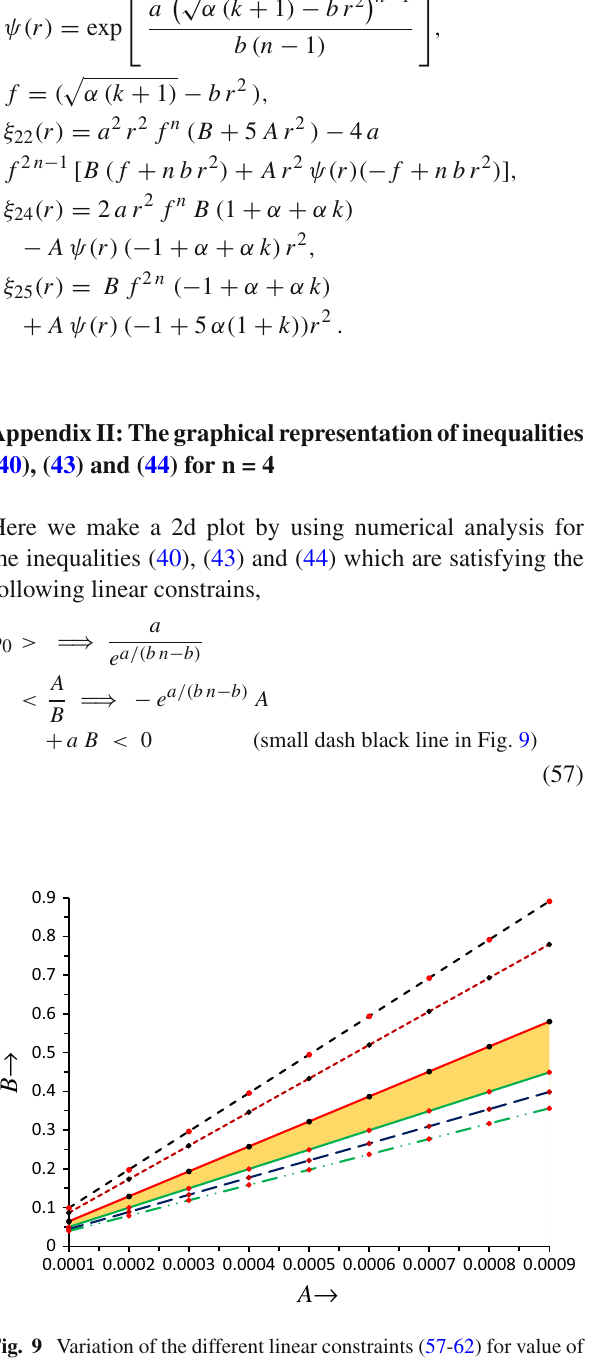
Fig. 9 Variation of the different linear constraints (57-62) for value of n = 4. For purpose of plotting this figure, We use the numerical values of the constants a and b which are mentioned in Table 1